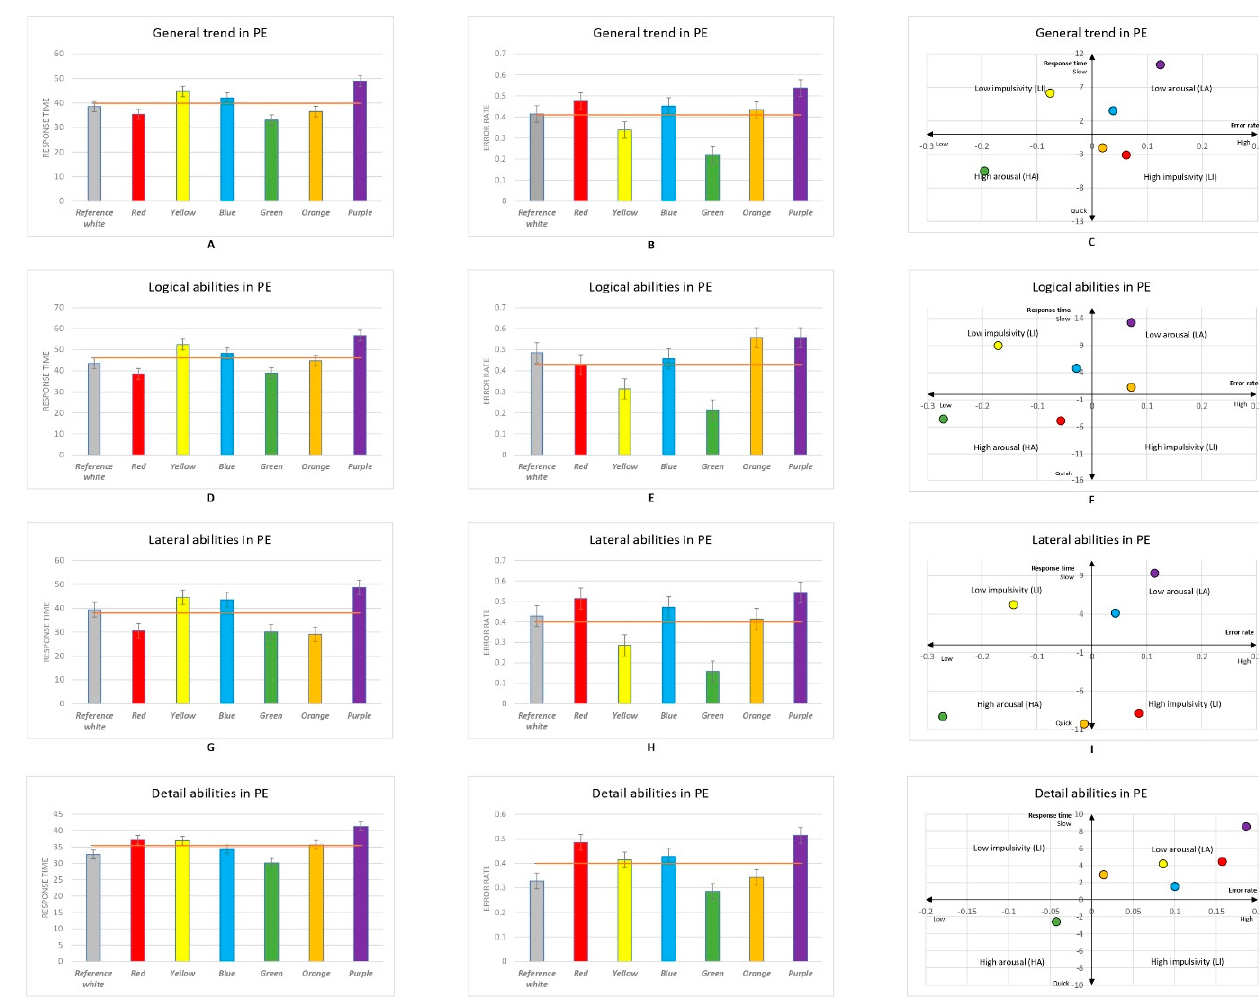
Figure 2. ( A ) General trend of response time by background colour in physical environment (PE); ( B ) general trend of error rate by background colour in PE; ( C ) colour impacts on general performance in PE visualised in the Error-Speed space; ( D ) response time of participants’ performance in logical abilities by background colour in PE; ( E ) error rate of participants’ performance in logical abilities by background colour in PE; ( F ) colour impacts on logical abilities in PE visualised in the Error-Speed space; ( G ) response time of participants’ performance in lateral abilities by background colour in PE; ( H ) error rate of participants’ performance in lateral thinking abilities by background colour in PE; ( I ) colour impacts on lateral thinking abilities in PE visualised in the Error-Speed space; ( J ) response time of participants’ performance in detail abilities by background colour in PE; ( K ) error rate of participants’ performance in detail abilities by background colour in PE; ( L ) colour impacts on detail abilities in PE visualised in the Error-Speed space. The bars represent mean changes, while the error bars are the standard error of the mean across individual participants. People’s responses to the reference white background are located on the centre axis in figures ( C , F , I , L ).